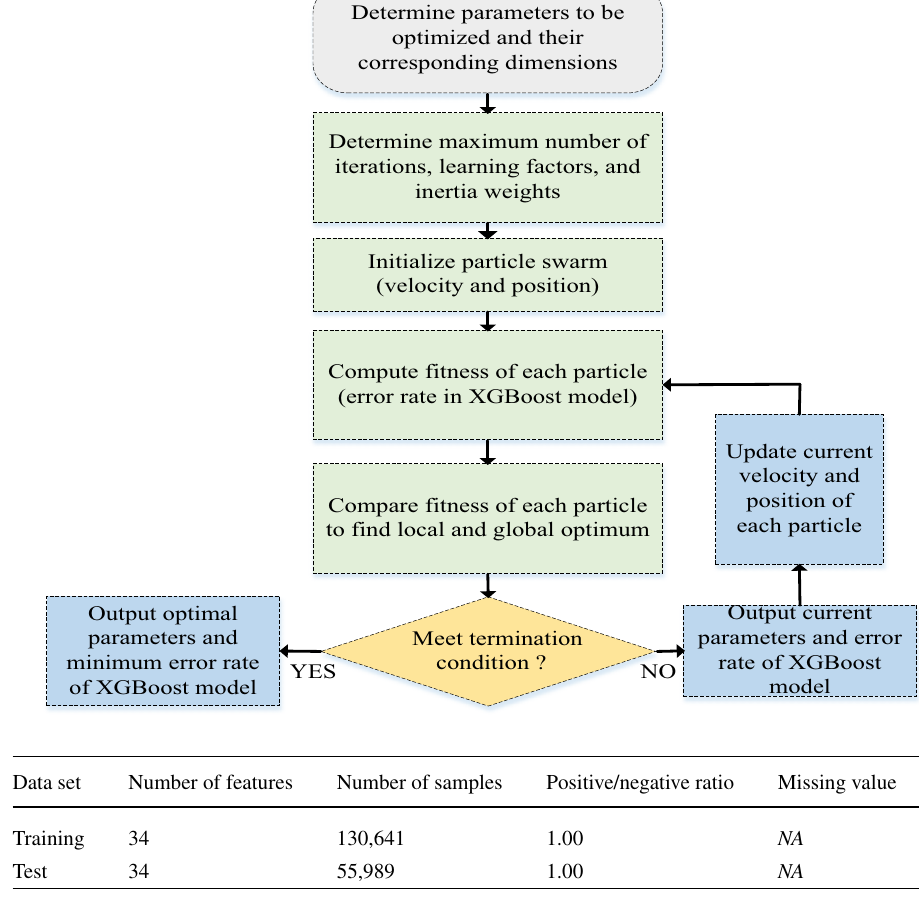
Fig. 5 Algorithm flow of PSO-XGBoost model Determine parameters to be